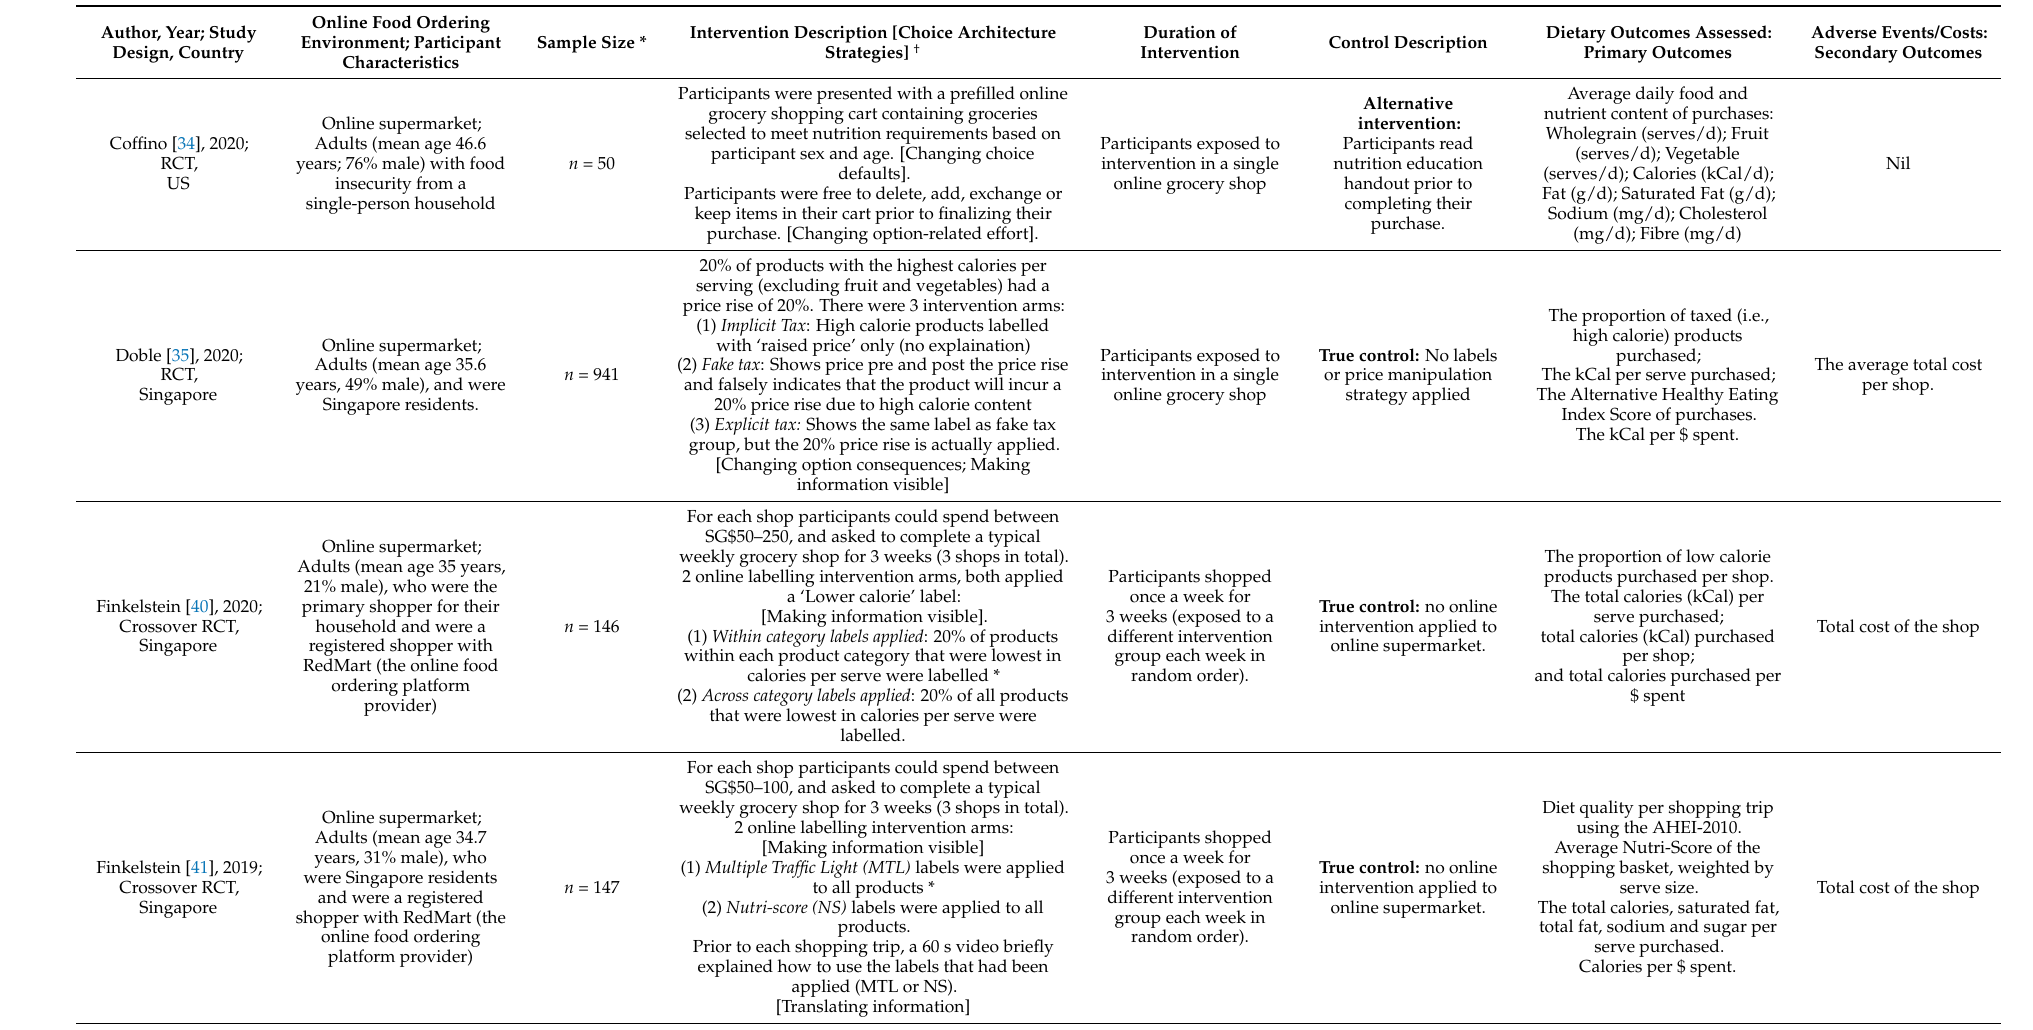
Table 1. Description of study